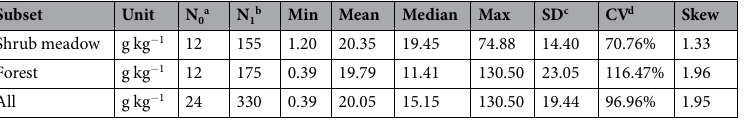
Table 1. Statistics for the concentration of organic carbon under the two land cover types. a Number of soil cores; b Number of all soil samples; c Standard deviation; d Coefficient of variation.